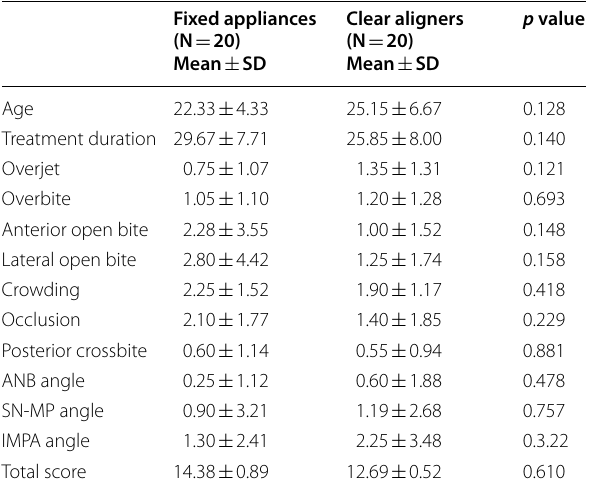
Table 1 Baseline characteristics and baseline discrepancy